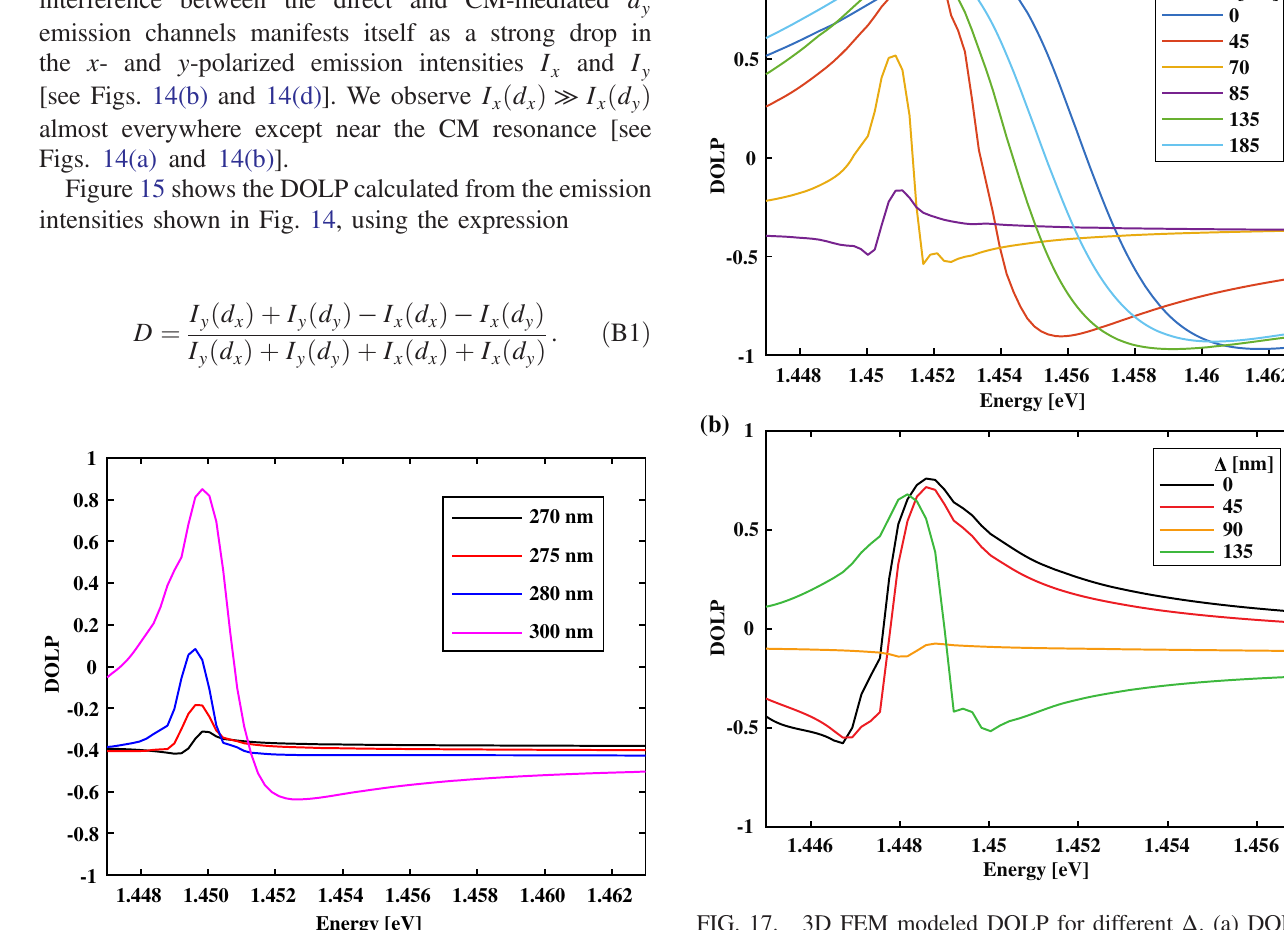
FIG. 16. 3D FEM modeled DOLP traces near the DOLP inversion at Δ ≈ 270 nm. DOLP was calculated as in Fig. 15.